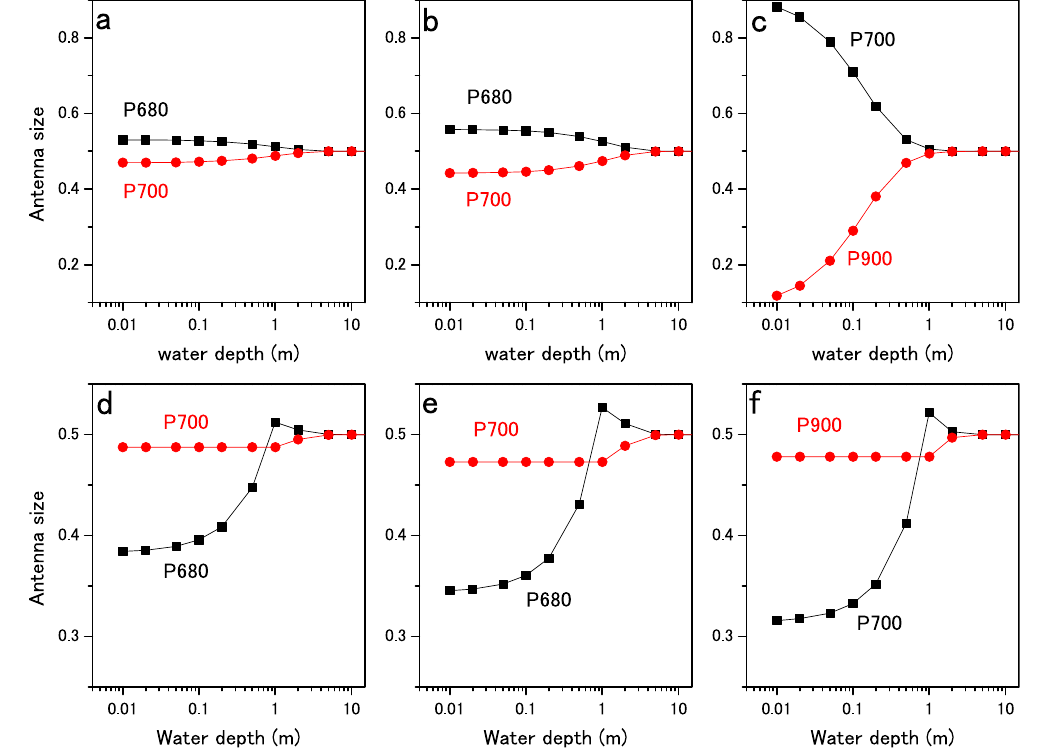
Figure 4. Light-harvesting antenna size regulation in shallow water. The changes in the light-harvesting antenna sizes for Earth-type two-photon reactions (P680 and P700) and heterogeneous reaction centers (P700 and P900) were calculated for the state transition model. Panels a and d show the antenna size changes for P680 (black squares) and P700 (red circles) under solar radiation. Panels b and e show the antenna size changes for P680 (black squares) and P700 (red circles) under AD Leo’s radiation. Panels c and f show antenna size regulation for P700 (black squares) and P900 (red circles) under AD Leo’s radiation. Effective antenna